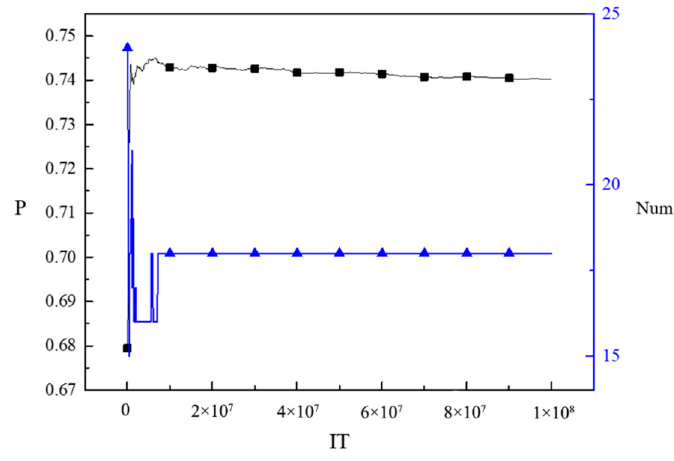
Figure 2. Probability of a stream not being selected in an iteration.